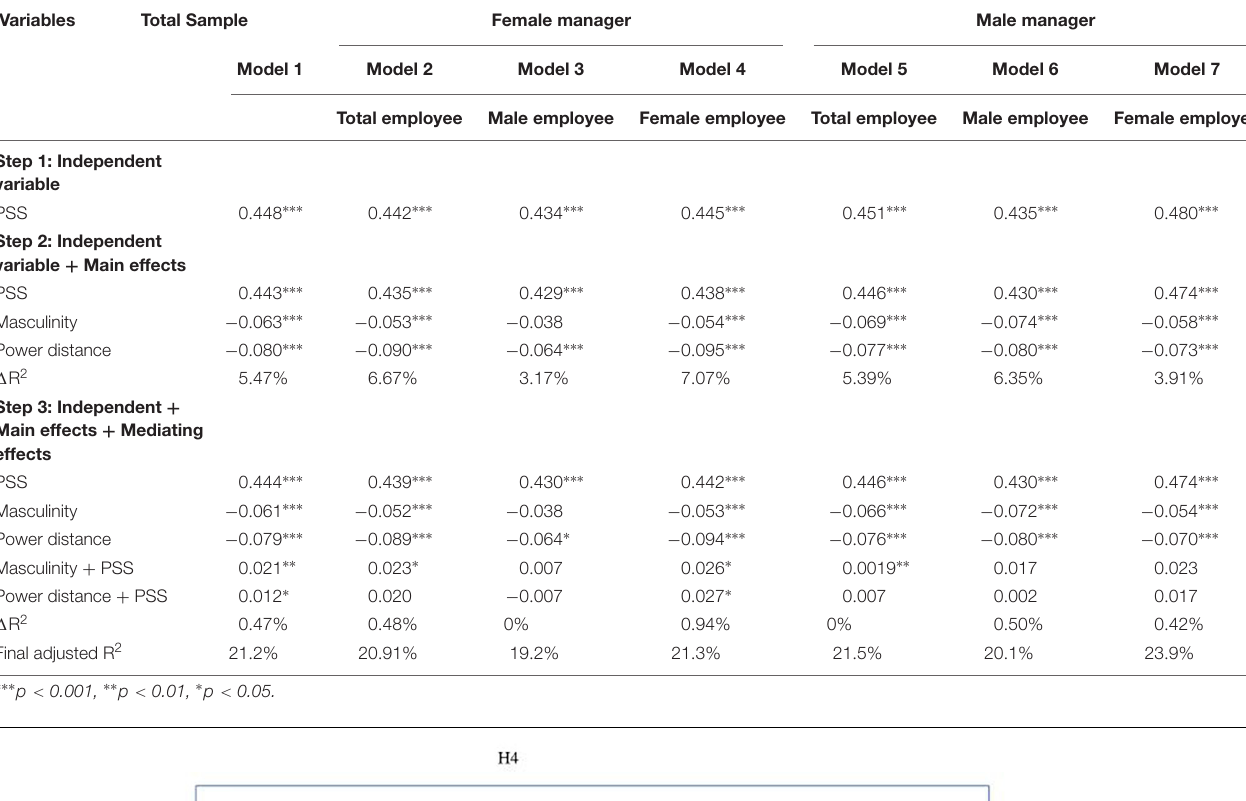
TABLE 7 | Results of the hierarchical regression models: direct employee participation (Standardized β -values). Variables